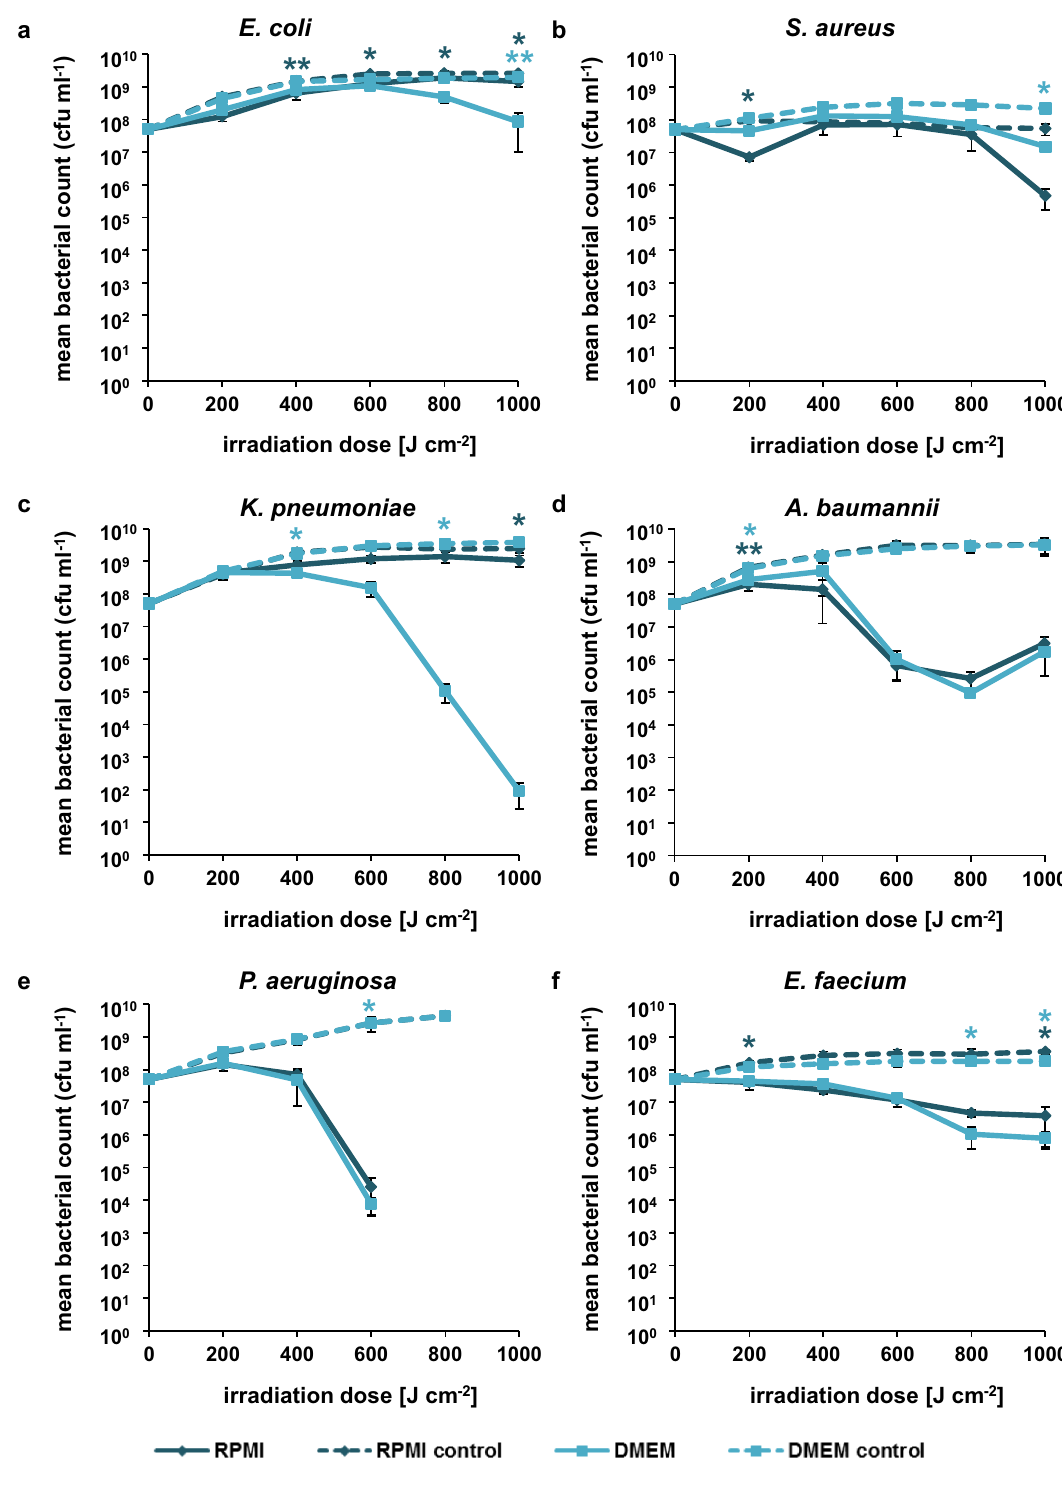
Figure 3. Survival of ESKAPE pathogens in the presence of RPMI and DMEM medium irradiated with 450 nm. ( a) E. coli . ( b ) S. aureus (ATCC43300). ( c ) K. pneumoniae . ( d ) A. baumannii . ( e ) P. aeruginosa (ATCC27853). ( f ) E. faecium . The values are expressed as log survival in comparison to starting bacterial density of 5 × 10 7 cfu ml −1 . The mean and standard deviation of three independent biological replicates with each three technical replicates are illustrated. Statistically significant differences between the irradiated samples and their respective controls are indicated with asterisks in the respective colors (* p < 0.05; ** p <